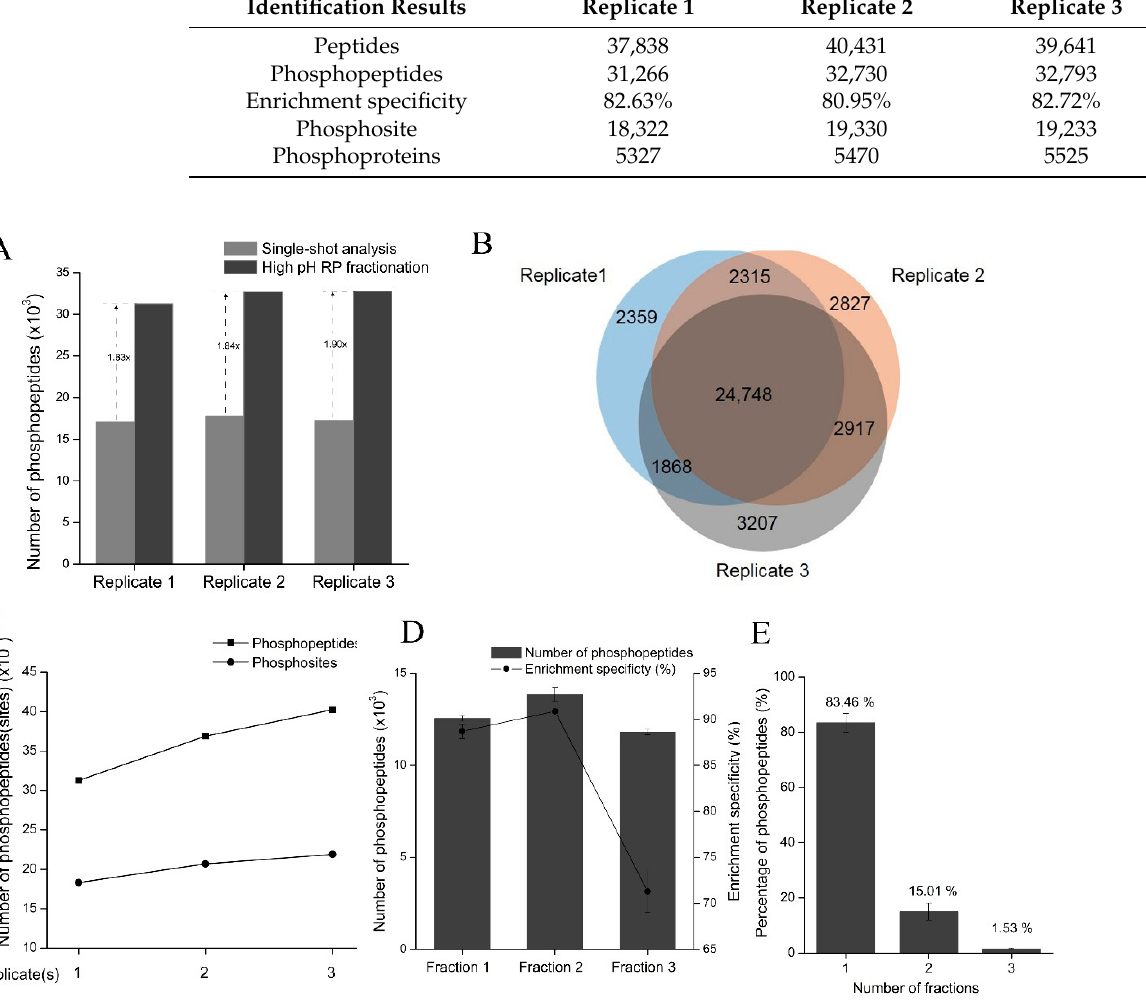
Figure 7. The TEA-based HpH-RP fractionation of phosphopeptides. ( A ) Compared with single-shot LC-MS/MS analysis, HpH-RP fractionation increases the number of phosphopeptides identified from the lactic acid method by nearly two-fold. Three replicates are performed for both single-shot analysis and HpH-RP fractionation. ( B ) The overlap of the phosphopeptides identified in the three replicates of HPH-RP fractionation. ( C ) The cumulative number of phosphopeptides and phosphosites identified in 293T cells. ( D ) The number of phosphopeptides identified and phosphopeptide enrichment specificity in the three fractions of the TEA-based HpH-RP fractionation. Bars show the mean ± SD of three replicates; error bars indicate standard deviation. ( E ) The separation efficiency of the TEA-based HpH-RP fractionation is shown as the percentage of phosphopeptides found in one or more fractions.